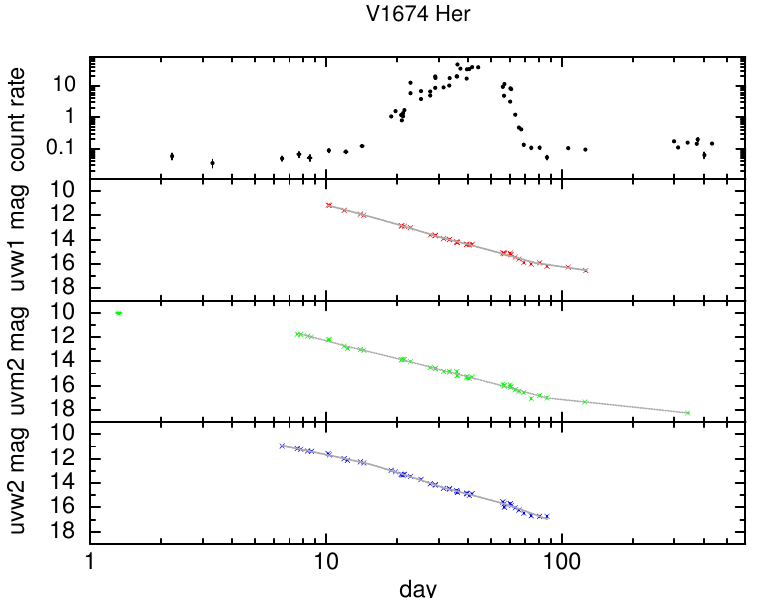
Figure 12. The XRT and UVOT light-curves of V1674 Her, with the best-fit broken power-law declines shown as the grey solid lines. The earliest bin in the uvm 2 light-curve has been excluded from the fit, since the break time cannot be constrained. The X-ray data (top) are in count s − 1 over 0.3–10 keV.